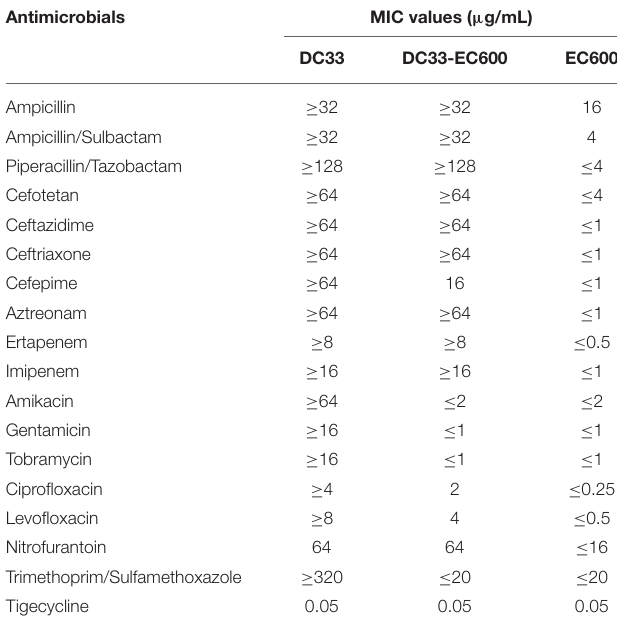
TABLE 1 | MIC values of antimicrobials for E. coli DC33 carrying bla NDM-13 and its